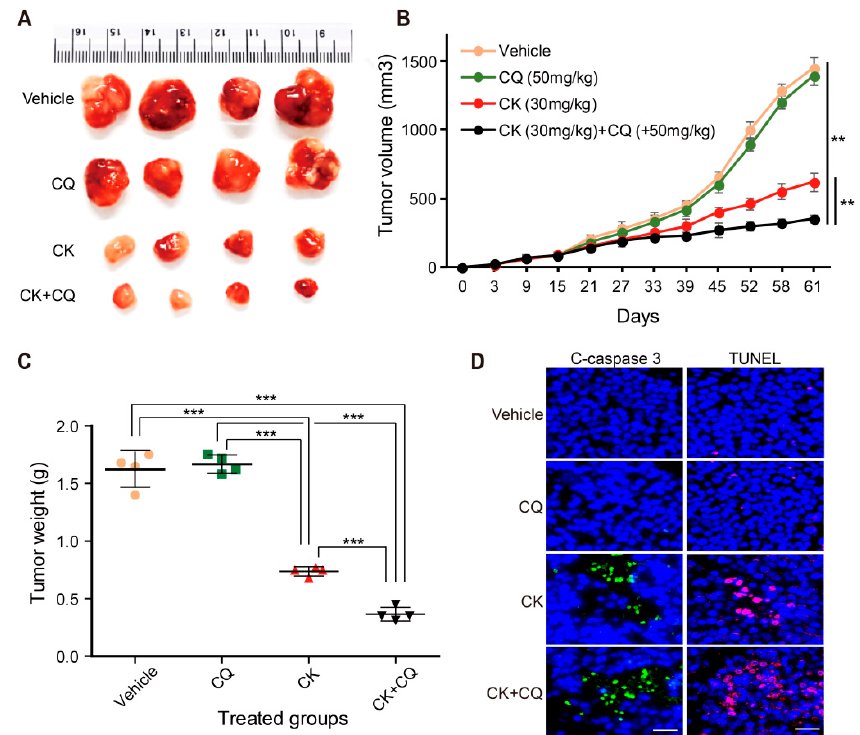
Figure 8. Inhibition of autophagy by CQ improves the CK-induced anti-tumor effect in neuroblastoma xenograft models. ( A – C ) Athymic nude mice bearing isogenic SK-N-BE(2) xenograft tumors were treated with vehicle (dimethyl sulfoxide, DMSO), CQ (50 mg / kg), CK (30 mg / kg), and CK in combination with CQ via intraperitoneal injection three times a week. Mice were sacrificed, and tumor samples were collected 61 days after cell injection. ( A ) The picture of di ff erent tumor groups. ( B ) Tumor growth curves represented the average values of 5 mice in each group. ( C ) Tumor weight is expressed in a scatter plot. Data ( B ) and ( C ) are presented as mean ± SD. **: p < 0.01, ***: p < 0.001 versus vehicle (DMSO treatment). ( D ) In each mouse tumor sample group, apoptosis was examined by immunohistochemical staining with cleaved caspase 3 antibody and TUNEL assay. Scale bar, 20 µm.